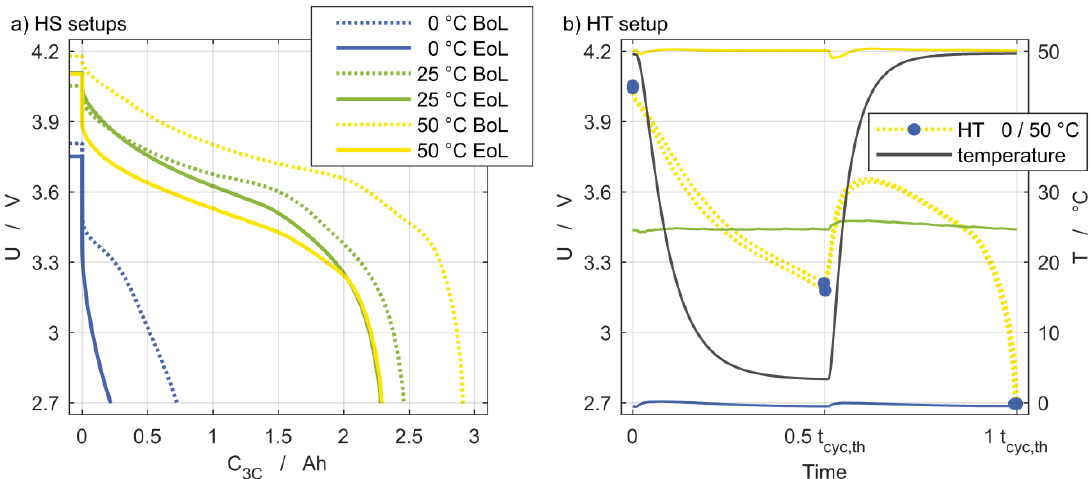
Figure 6. ( a ) Voltage curves for the three reference temperatures at the BoL and EoL states. ( b ) Temperature for the homogeneous setup and the voltage curve for HT 0/50 °C as an example.